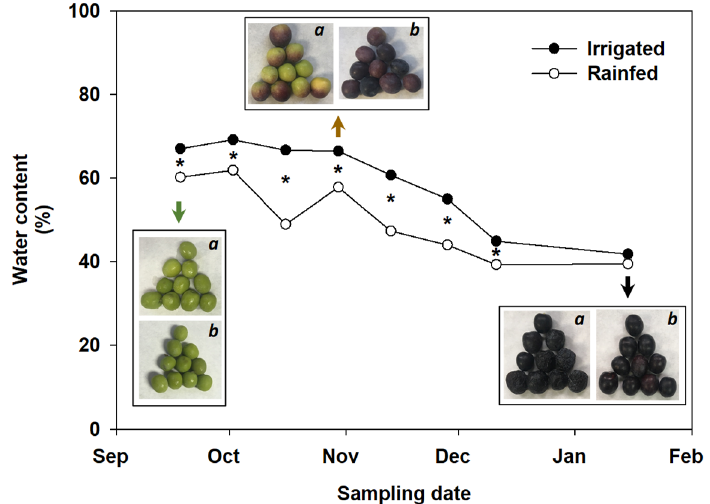
Figure 3. Water content (%) and appearance of ‘Arbequina’ olives during on-tree ripening under irrigated and rain-fed conditions. Letters ( a ) and ( b ) on the images identify fruits from irrigated and non-irrigated trees, respectively. Water content values represent the average of 3 replicates (10 fruits/replicate). Asterisks stand for significant differences between irrigated and non-irrigated trees at p ≤ 0.05 (LSD test).